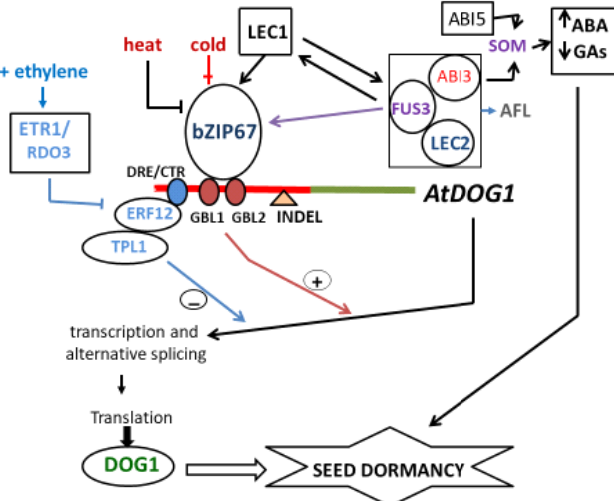
Figure 3. A model for the transcriptional regulation of DOG1 gene by ethylene and low temperatures (promotor in red; coding region in green) to induce PD in A. thaliana (adapted from Li et al. 2019 [44]; Carbonero et al. 2017 [45], and Breeze et al. 2019 [46]). Downstream of the GBL1 cis -element is